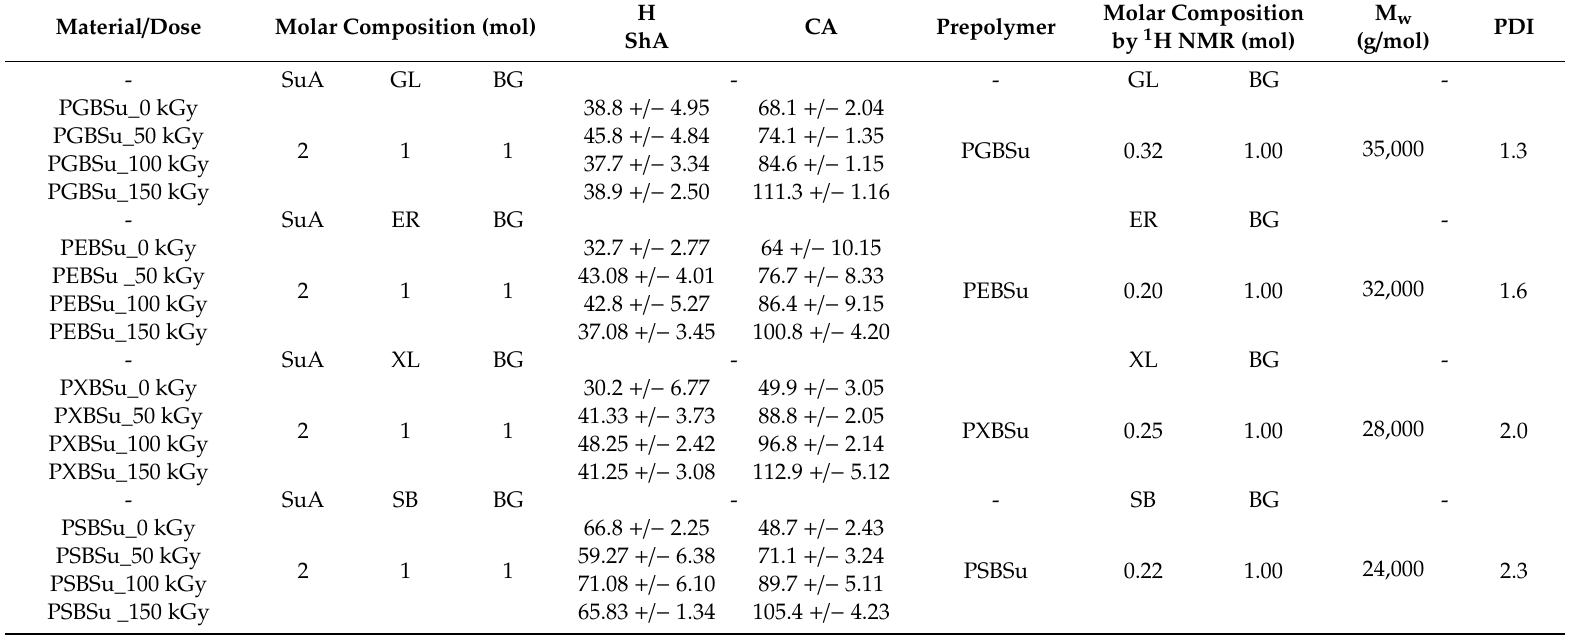
Table 1. Selected properties and composition of poly(glycerol succinate-co-butylene succinate) (PGBSu), poly(erythritol succinate-co-butylene succinate) (PEBSu), poly(xylitol succinate-co-butylene succinate) (PXBSu), poly(sorbitol succinate-co-butylene succinate). Data for both non-irradiated and radiation-modified materials is